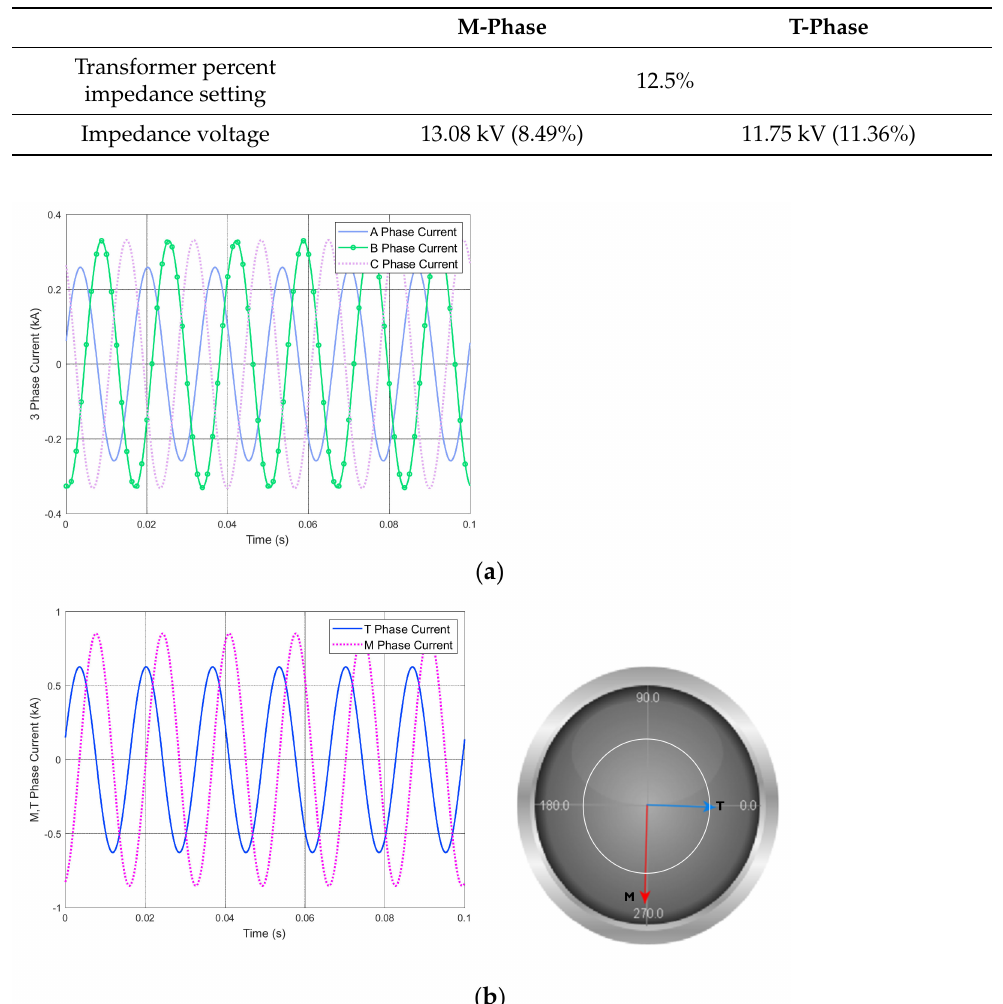
Table 1. Impedance voltage test results of the Library Scott transformer model when the input parameter (percent impedance, %Z) is set as 12.5%.